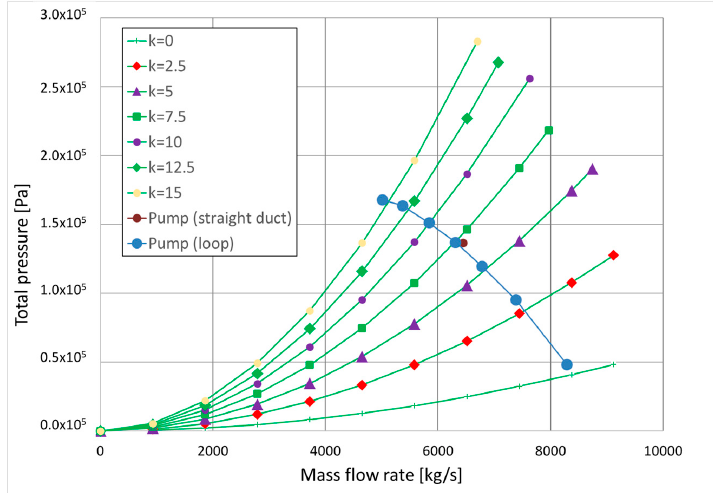
Figure 15. Characteristic curve of the pump, of the loop and operating point of the pump into the straight